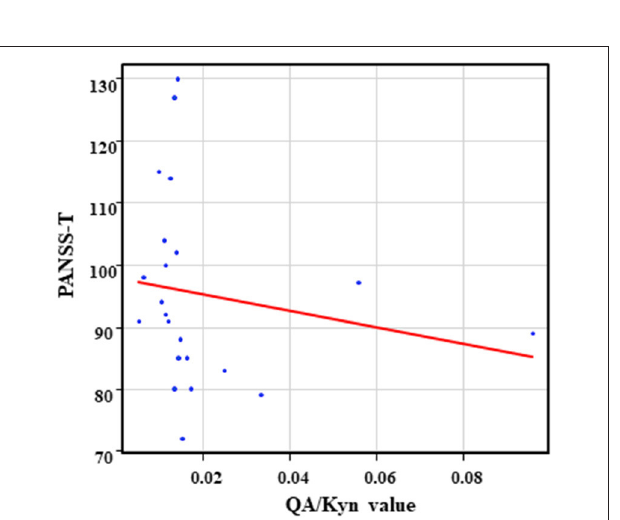
FIGURE 11 | Association between the PANSS-T scores and the QA/Kyn value in the schizophrenia group. A negative correlation was found between the PANSS-T sore and the QA/Kyn value ( r = − 0.50, p = 0.017) in the schizophrenia